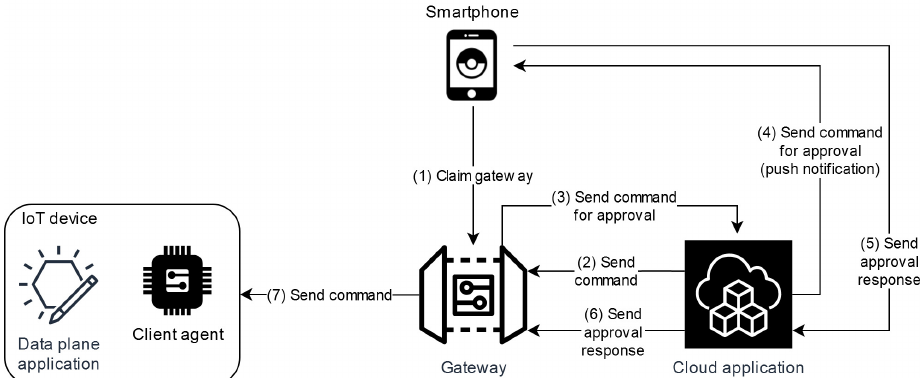
Figure 4. Smartphone claim and approval command